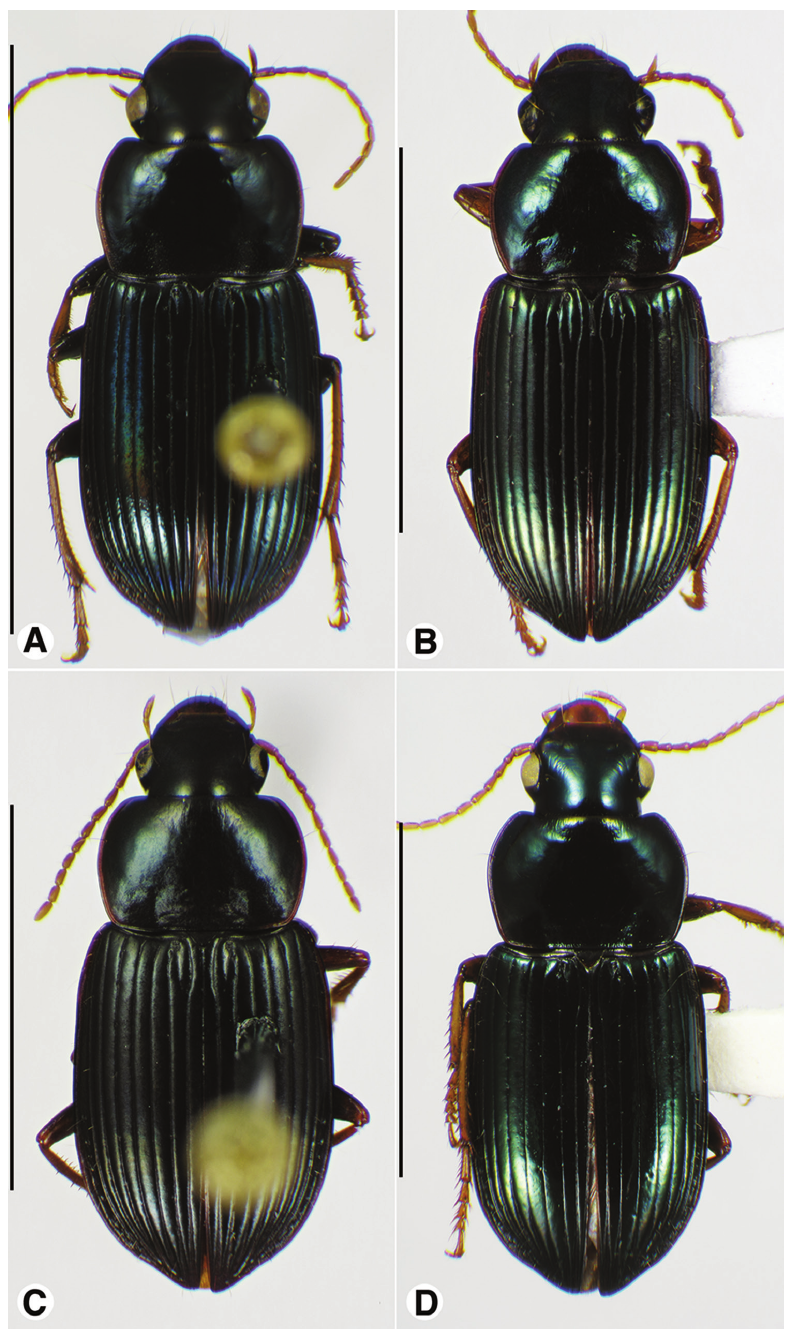
Figure 39. Habitus digital images of Selenophorus opalinus species group, in part, dorsal aspect. A S. fabricii sp. n. B S. flavilabris cubanus Darlington C S. flavilabris flavilabris Dejean D S. flavilabris ubancus Ball & Shpeley. Scale bars: A 10 mm; B–D 5